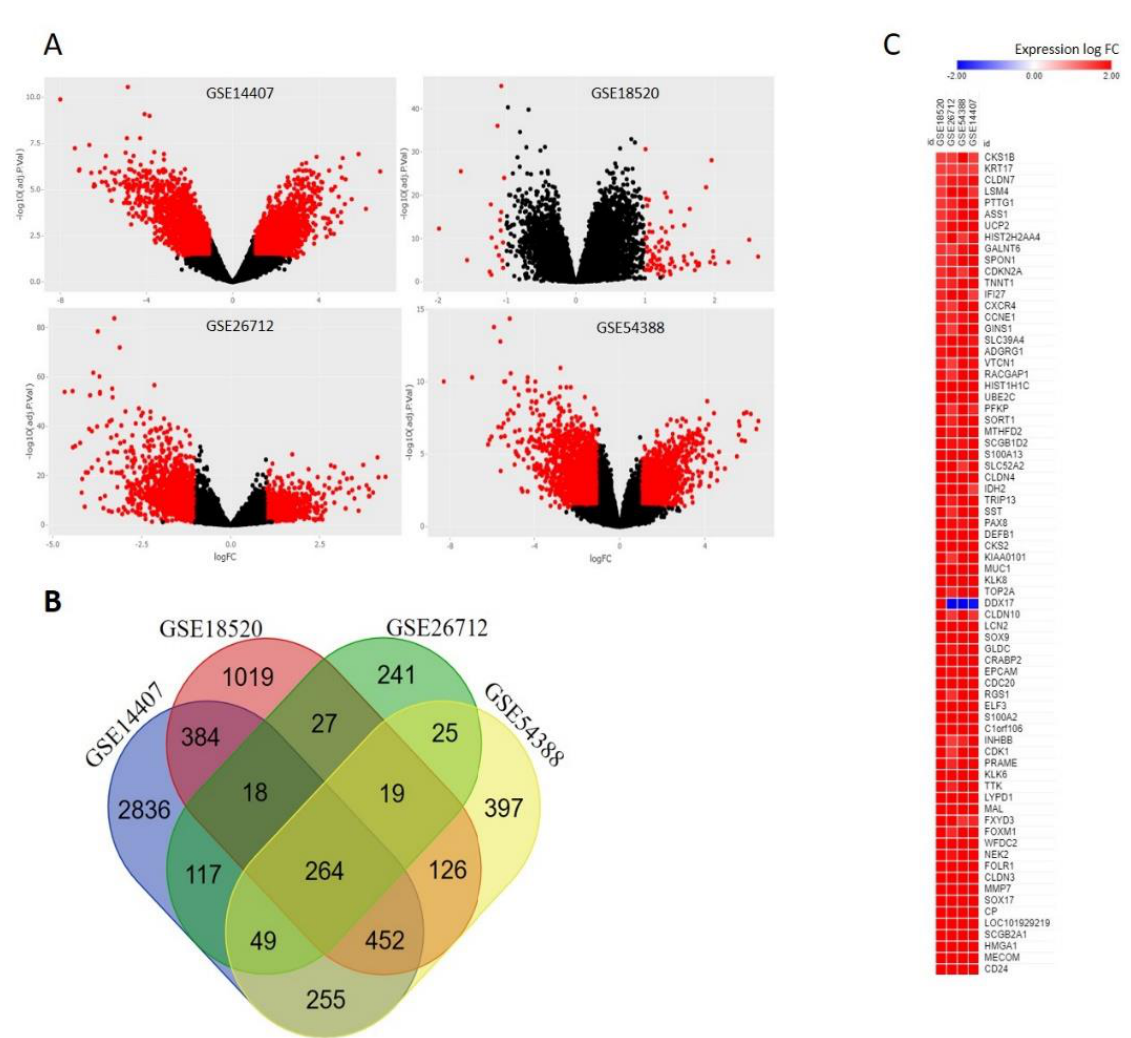
Figure 1. Identification of differentially expressed genes (DEGs). ( A ) Differential expression of genes between cancerous and non-cancerous samples in the datasets; GSE14407, GSE18520, GSE26712, GSE54388, the red data points in the volcano plot represent upregulated and downregulated genes screened based on |LOG FC| > 1.5 and a corrected p -value of <0.05. The black data points represent genes with no significant difference. The datasets were obtained from gene expression omnibus. ( B ) Venn diagram of common DEGs in the 4 datasets; a total of 264 DEGs overlapped in all 4 datasets. ( C ) The heat map of relative common upregulated gene signature and the GEO datasets. Each column in the figure represents a GEO dataset and each row represents a gene. The colors in the graph explain the magnitude of gene expression in datasets. The red color indicates that the gene is highly expressed in the dataset and the blue indicates that the gene expression is low. Table 1. Microarray datasets of ovarian cancer patients.